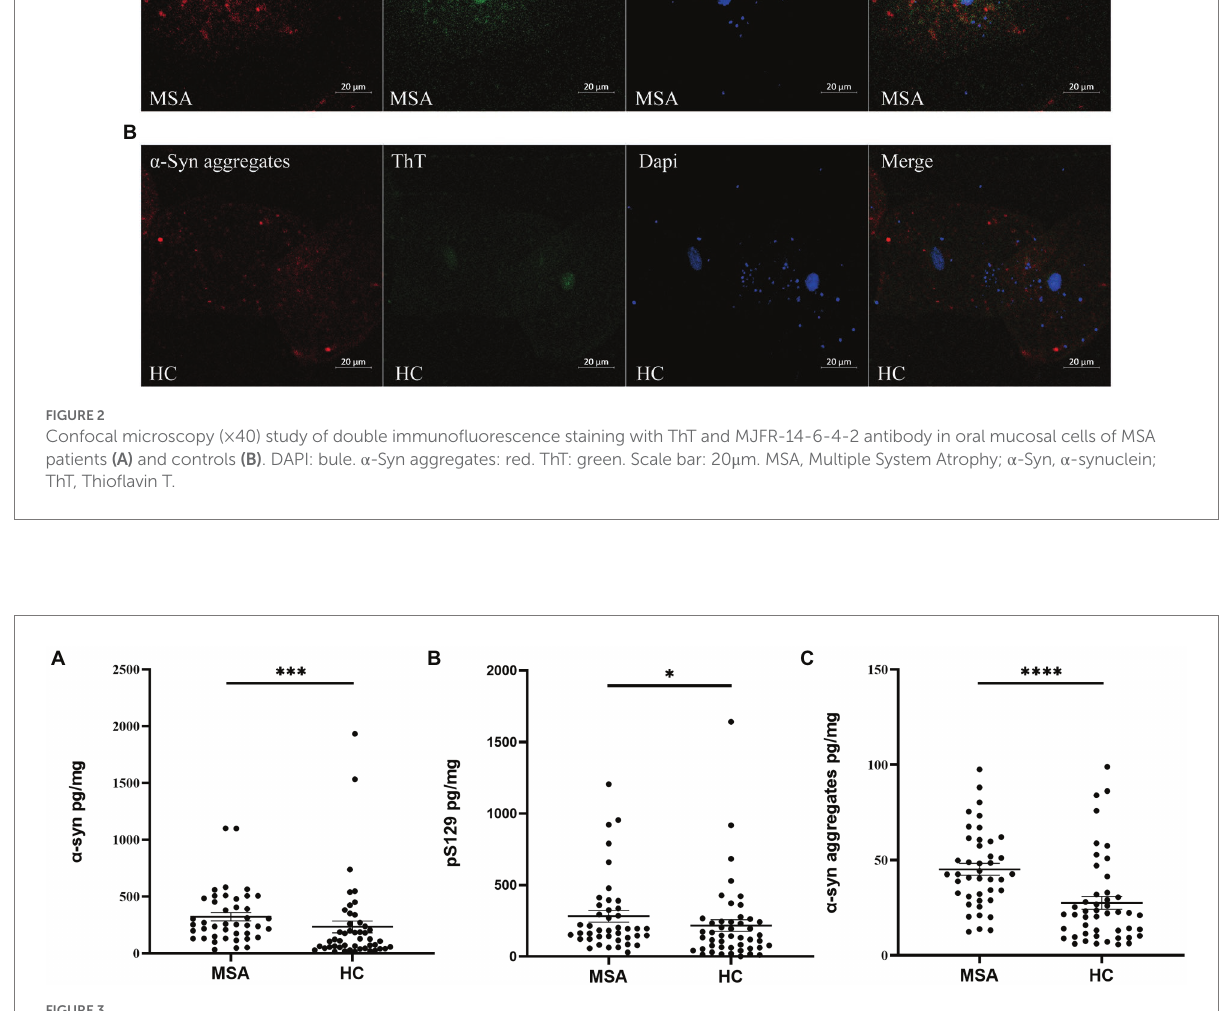
FIGURE 3 The concentrations of α -Syn, pS129, and α -Syn aggregates in oral mucosa samples of MSA patients and controls. (A) α -Syn, normalized to total oral mucosal cell proteins (pg/mg); *** p < 0.001 (Mann–Whitney U test); (B) pS129, normalized to total oral mucosal cell proteins (pg/mg); * p = 0.042 (Mann–Whitney U test); (C) α -Syn aggregates, normalized to total oral mucosal cell proteins (pg/mg); **** p < 0.0001 (Mann–Whitney U